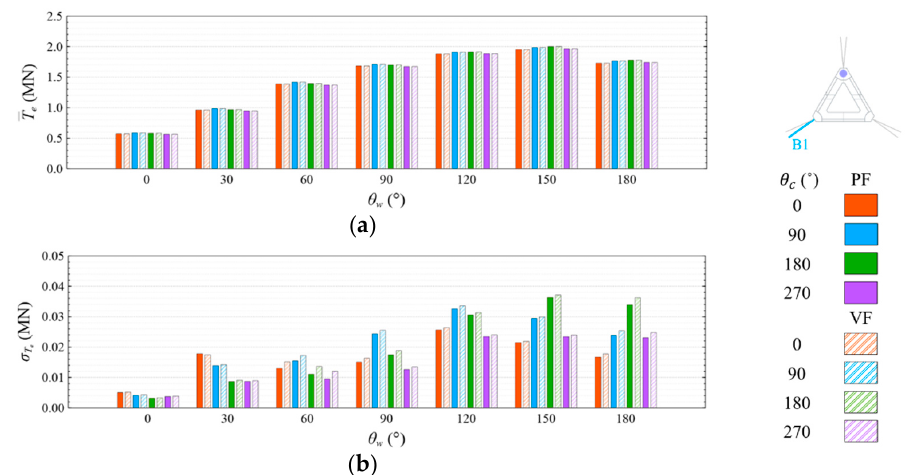
Figure 30. Comparison of ( a ) means and ( b ) standard deviations of mooring line tension of Line B1